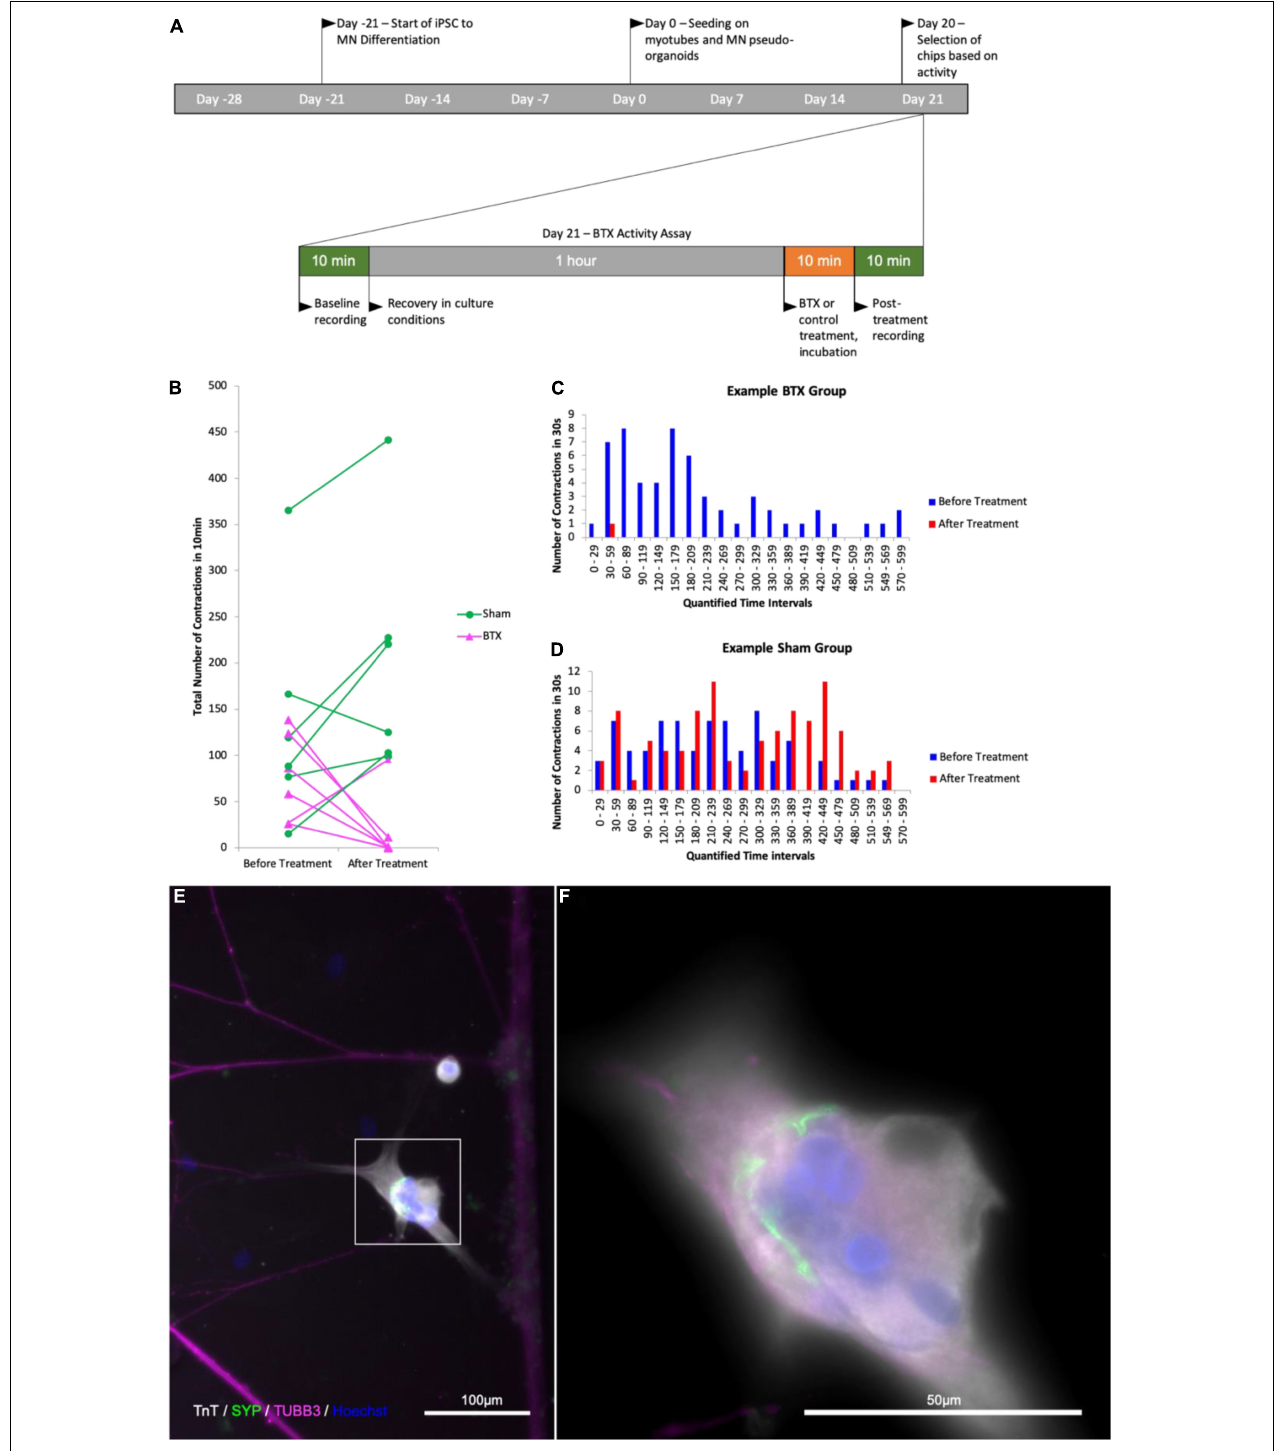
FIGURE 7 | Quantification of contractile activity before and after -Bungarotoxin application BTX binding at myotube surface. Outline of experimental timeline (A) , total number of contractions in a 10 min time interval in a myotube in contact with one or more axons in the control and BTX-treated groups before and after treatment (B) number of observed myotube contractions in 30 s intervals before and after treatment in a myotube in the BTX-treated (C) and sham-treated (D) groups. (E) Image of myotube and MN axons after BTX application. (F) Higher magnification of the myotube in the area boxed in (E) ; Troponin T (TnT, grays), α -Bungarotoxin (BTX, green), and beta-III-tubulin (magenta), nuclear stain Hoechst (blue).